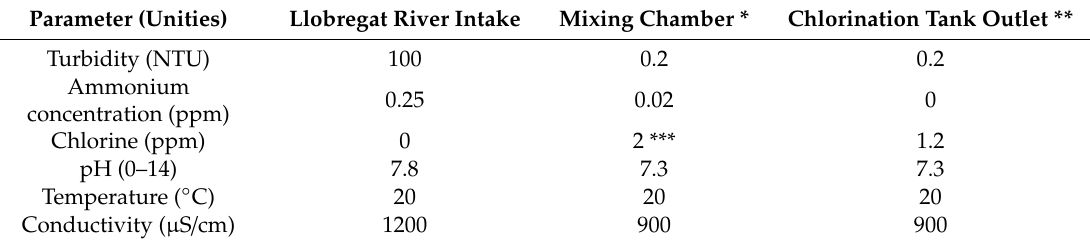
Table 1. Parameters of water at di ff erent sampling points in the